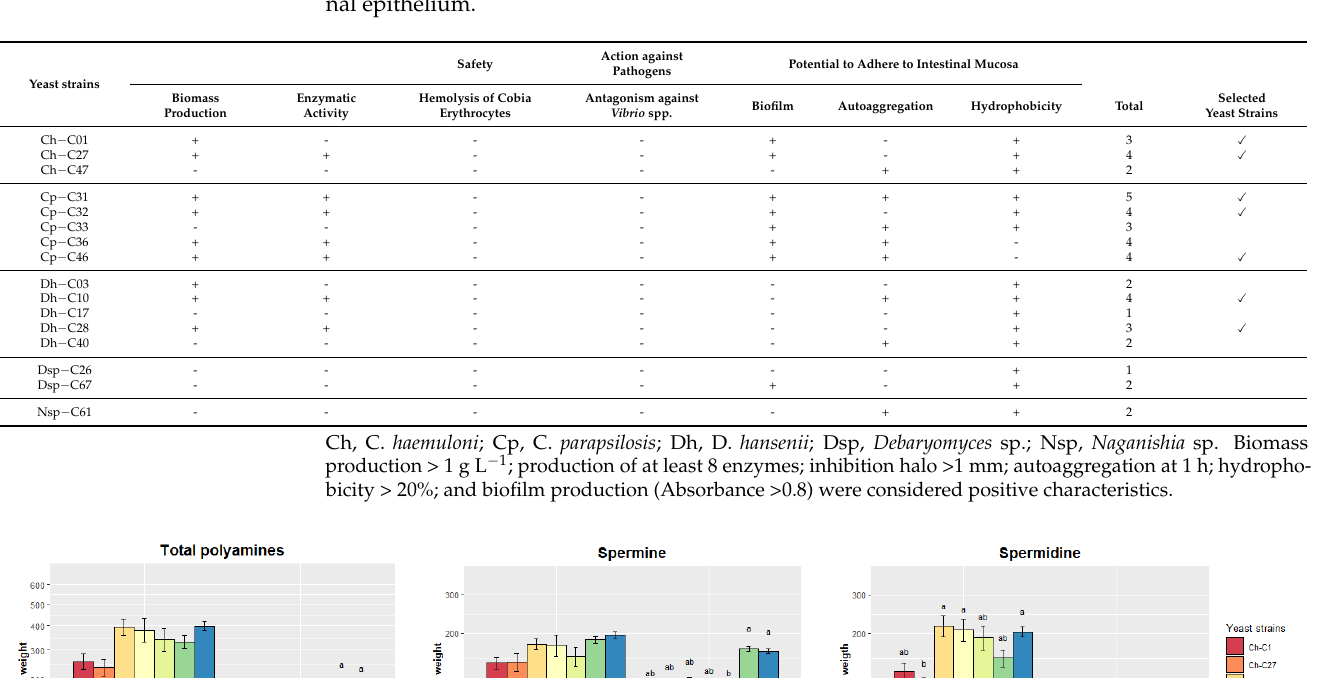
Table 4. Characteristics of selected yeast strains (checked) according to their biomass production, hemolysis, and enzymatic activity; antipathogen effect; and their potential to adhere to the intesti- nal epithelium.